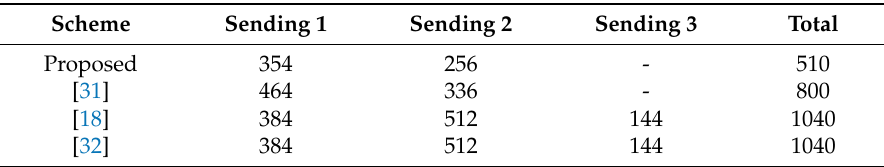
Table 3. The comparison in communication cost